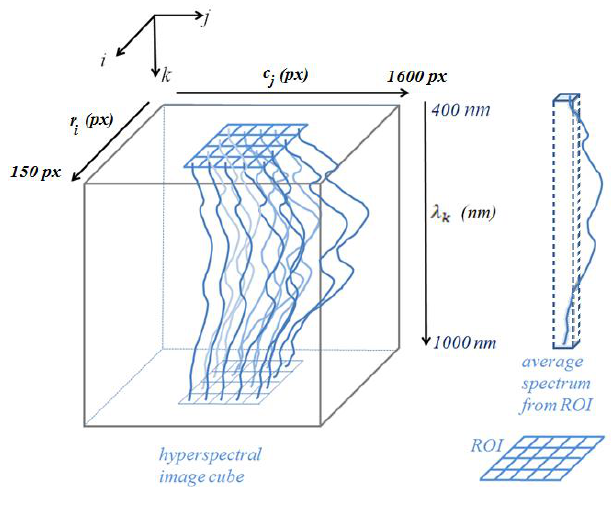
Figure 4. Representation of a hyperspectral image cube, and the region of interest (ROI) that is ensemble averaged to obtain a single spectrum. The ROI represents the red rectangle in Figure 2. The spectra associated with a pixel location, (i , j) , (top view) include multiple central wavelengths λ – λ , where λ = 400 nm and λ = 1,000 nm. c represents the column 1 n 1 n j pixel (px) (sample) value at location j ; r is the row pixel (line) value at i . λ represents the i k different wavelengths of the spectra at wavebands k